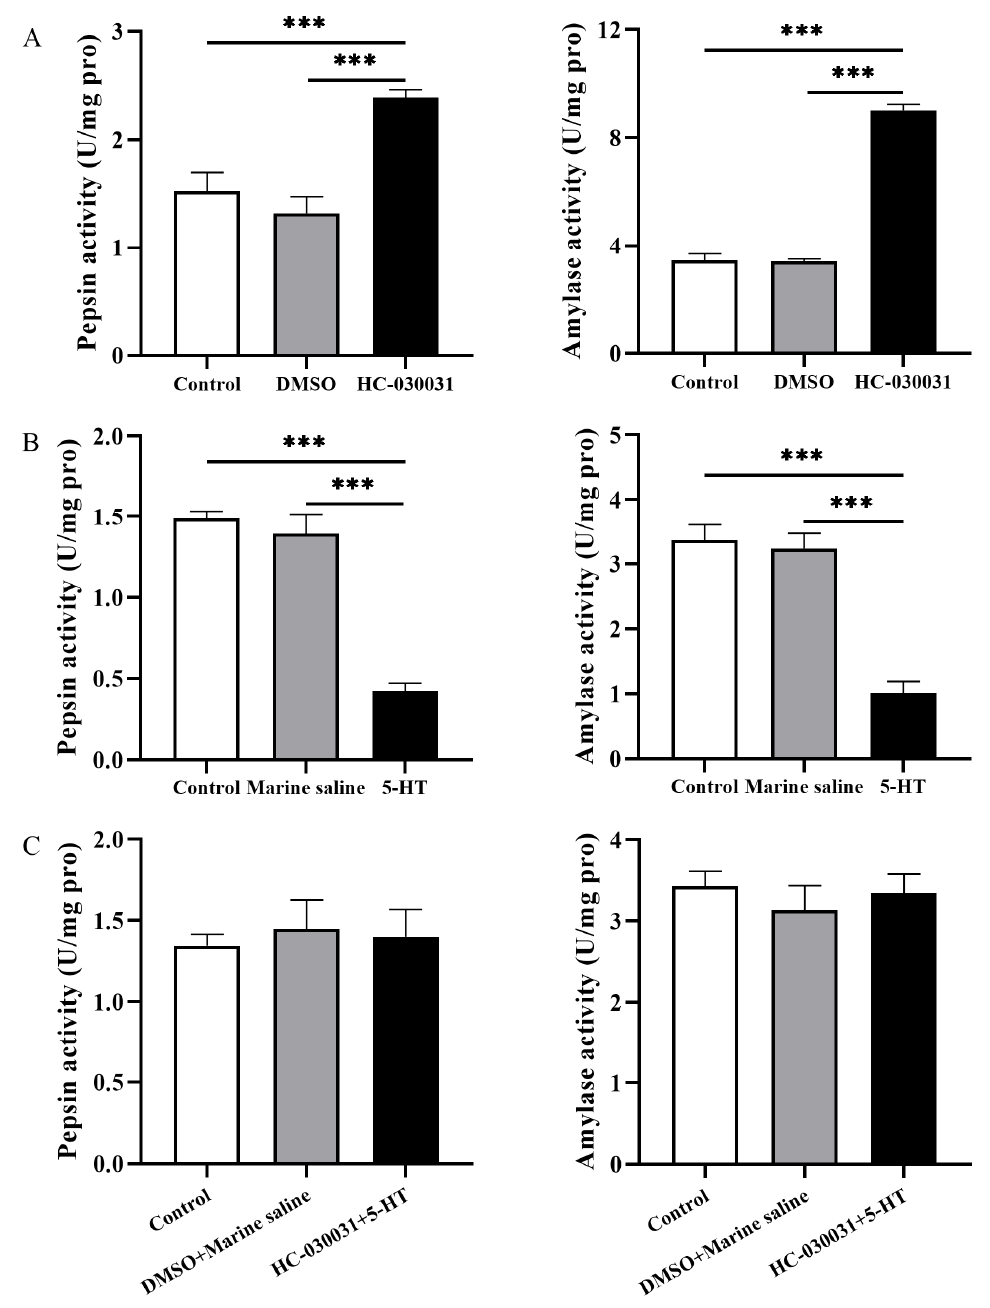
Figure 5. Digestive enzyme activities are negatively correlated with the reciprocal regulation of TRPA1 and 5-HT in the gut of Strongylocentrotus intermedius. ( A ) The activities of pepsin and amylase of the control, DMSO, and HC-030031 groups ( n = 5). ( B ) The activities of pepsin and amylase of the control, marine saline, and 5-HT groups ( n = 5). ( C ) The activities of pepsin and amylase of control, DMSO + marine saline, and HC-030031 + 5-HT groups ( n = 5). The symbol *** means p < 0.001 (mean ± s.e.m.).